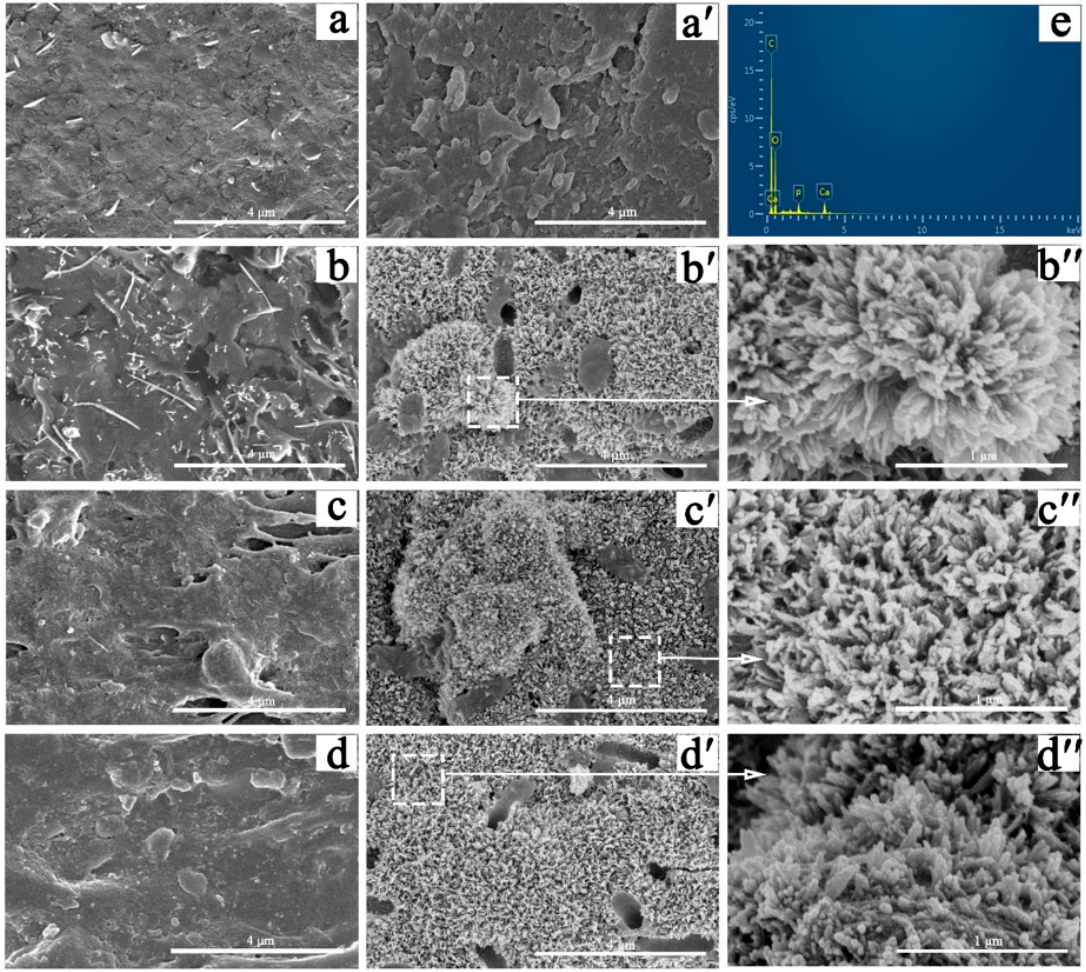
Figure 5. Apatite-formation on the PAA and composites after immersion in SBF for 7 days. The SEM photographs of the PAA and the composites before soaking in SBF: ( a ) PAA, ( b ) 30P/PAA, ( c ) 40P/PAA, ( d ) 50P/PAA (scale bar = 4 µm); and after soaking in SBF for 7 days: ( a ′ ) PAA, ( b ′ ) 30P/PAA, ( c ′ ) 40P/PAA, ( d ′ ) 50P/PAA (scale bar = 4 µm), ( b ′′ ) 30P/PAA (scale bar = 1 µm); ( c ′′ ) 40P/PAA (scale bar = 1 µm); ( d ′′ ) 50P/PAA (scale bar = 1 µm); ( e ) EDS spectra of the 50P/PAA composite after SBF soaking 7 days.